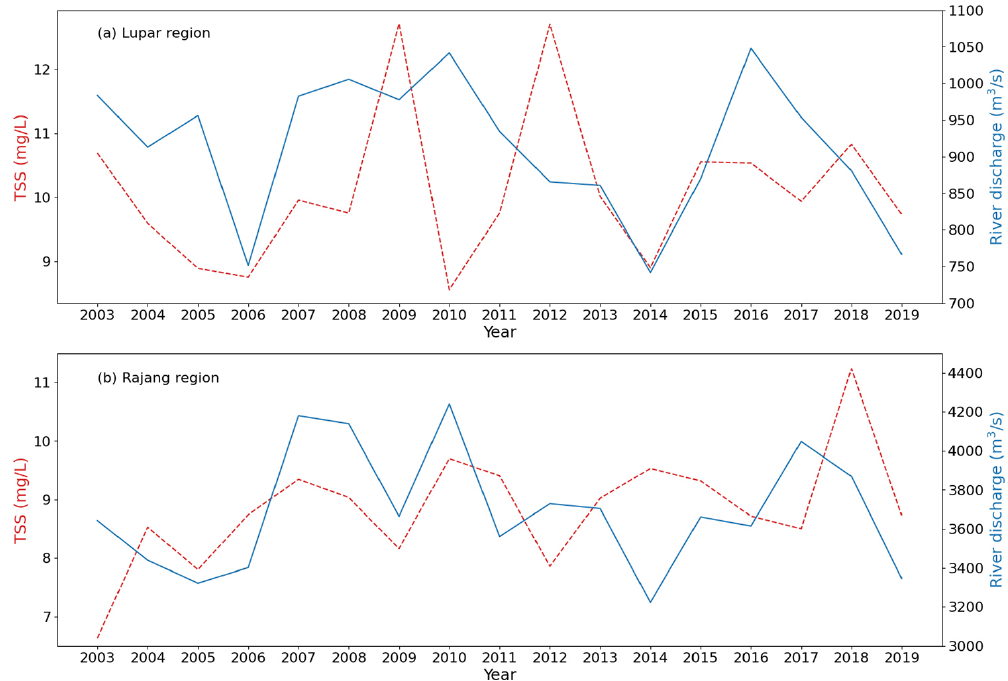
Figure 9. Time series analysis of river discharge (m 3 s − 1 ) in relation to TSS concentrations (mgL − 1 ) for the Lupar (a) and Rajang (b) basins from the year 2003 to 2019. Note the differing scaling on the ordinate axes in each plot.